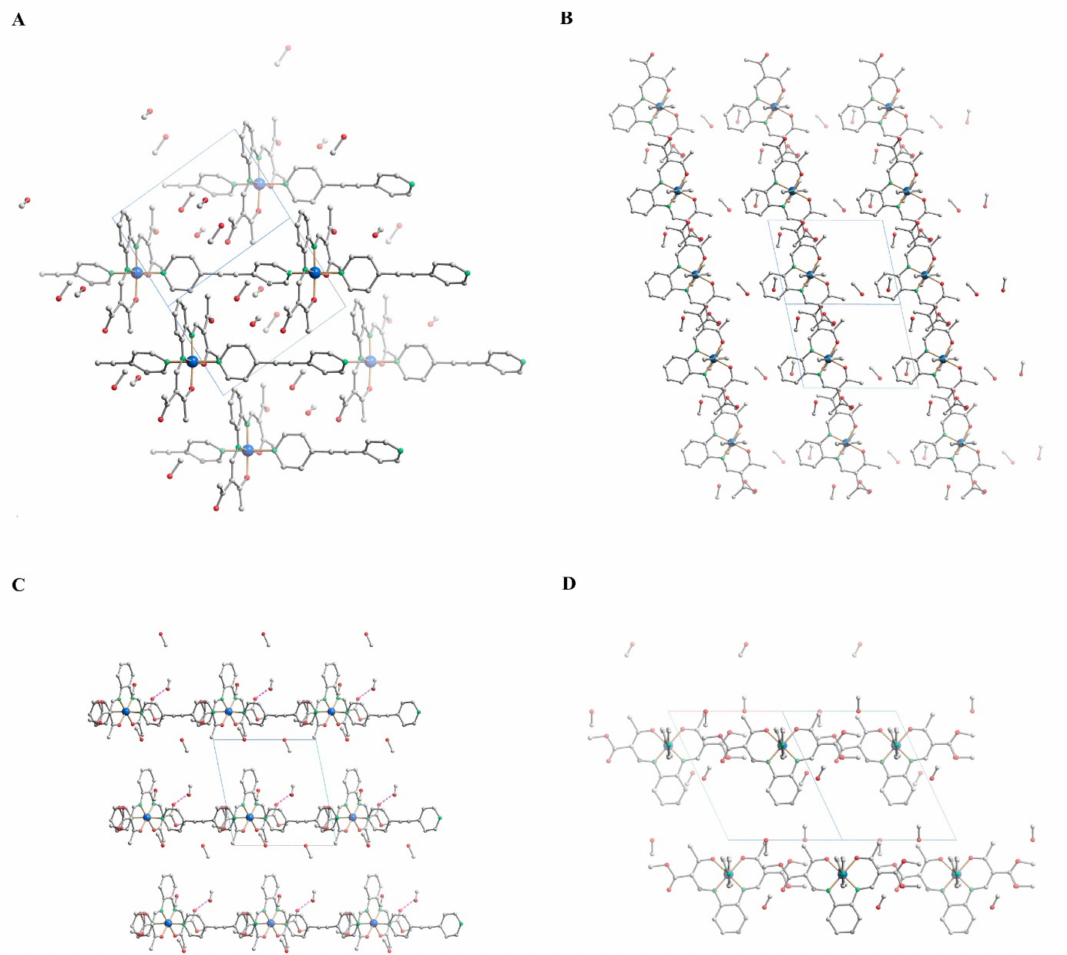
Figure 2. Molecular packing of 1b (A, along [011] and B, along [ − 1 − 10]), and 3b (C, along [010] and D, along [ − 110]) in the crystal. Hydrogen atoms not involved in hydrogen bonds were omitted for clarity. Hydrogen bonds are drawn as pink, dashed